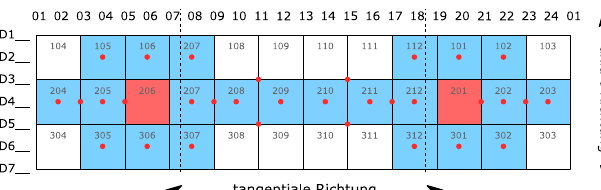
TABLE I R ESULTS FOR DIFFERENT DETECTOR ARRANGEMENTS